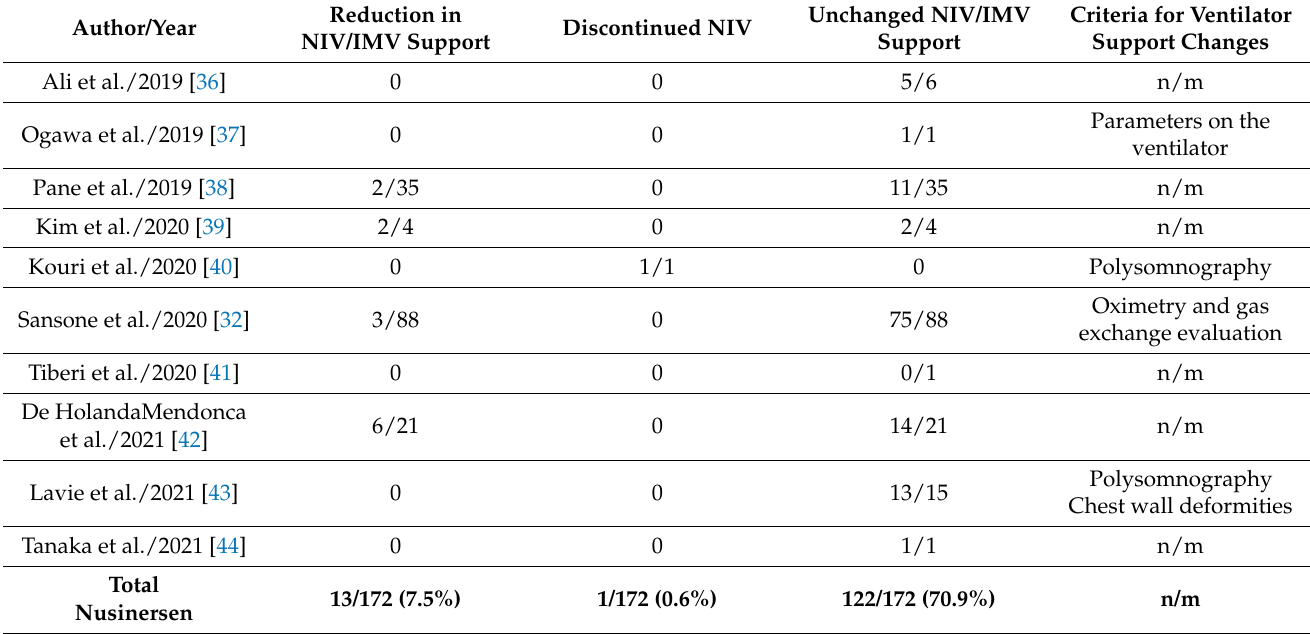
Table 3. Changes in ventilatory support requirements following treatment with